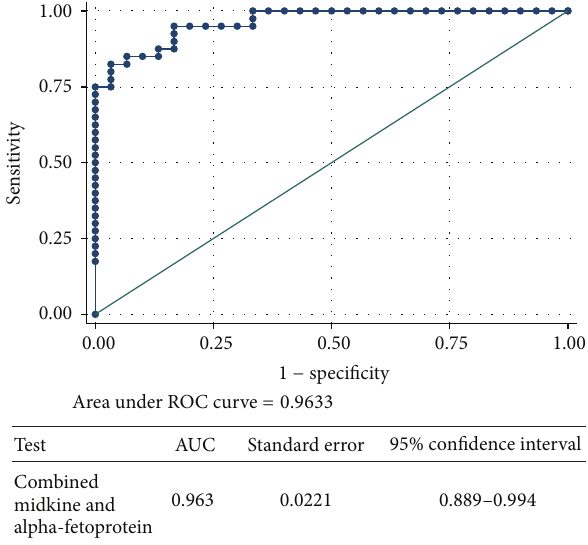
Figure 4: ROC curve for combined midkine and alpha-fetoprotein for discrimination between HCC and